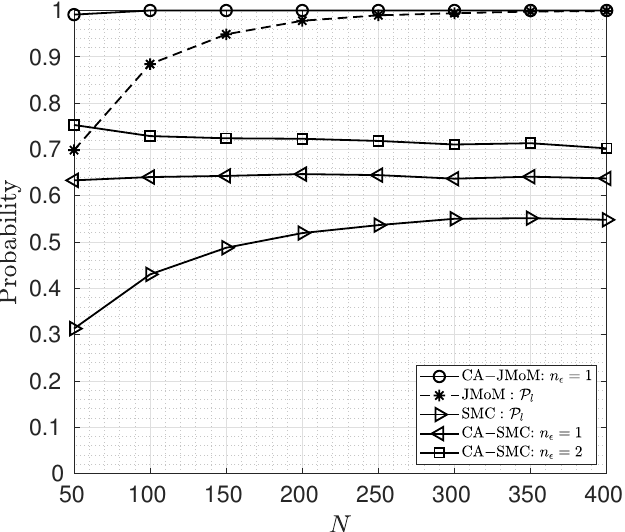
Figure 3. Lock-in probability for different values of OFDM symbols used for